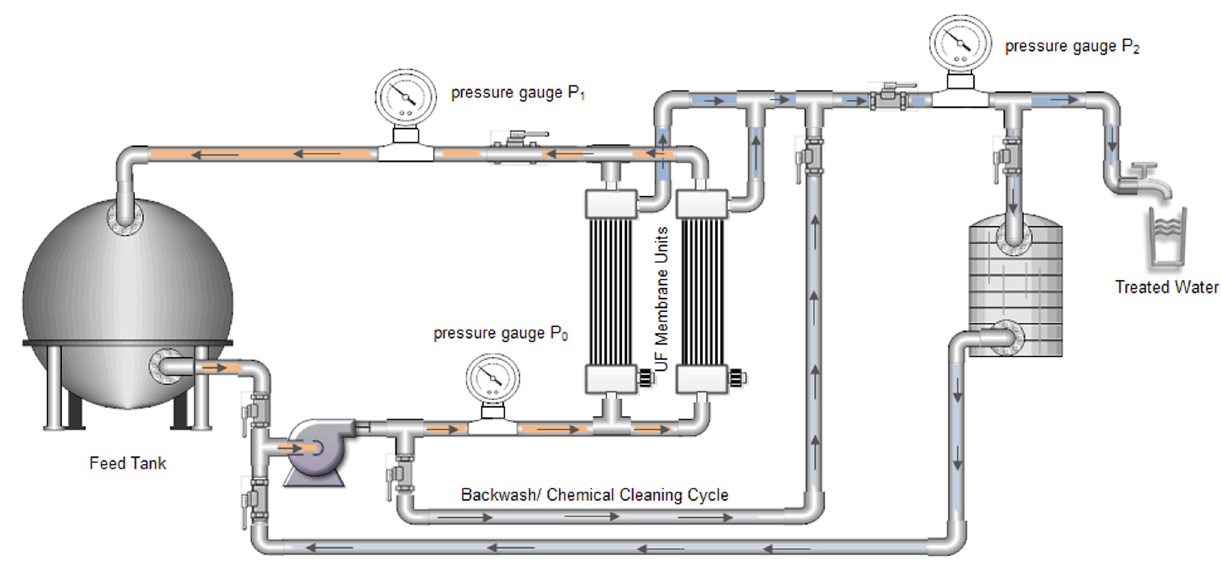
Figure 6: The use of ultra fi ltration membrane system for virus removal from domestic